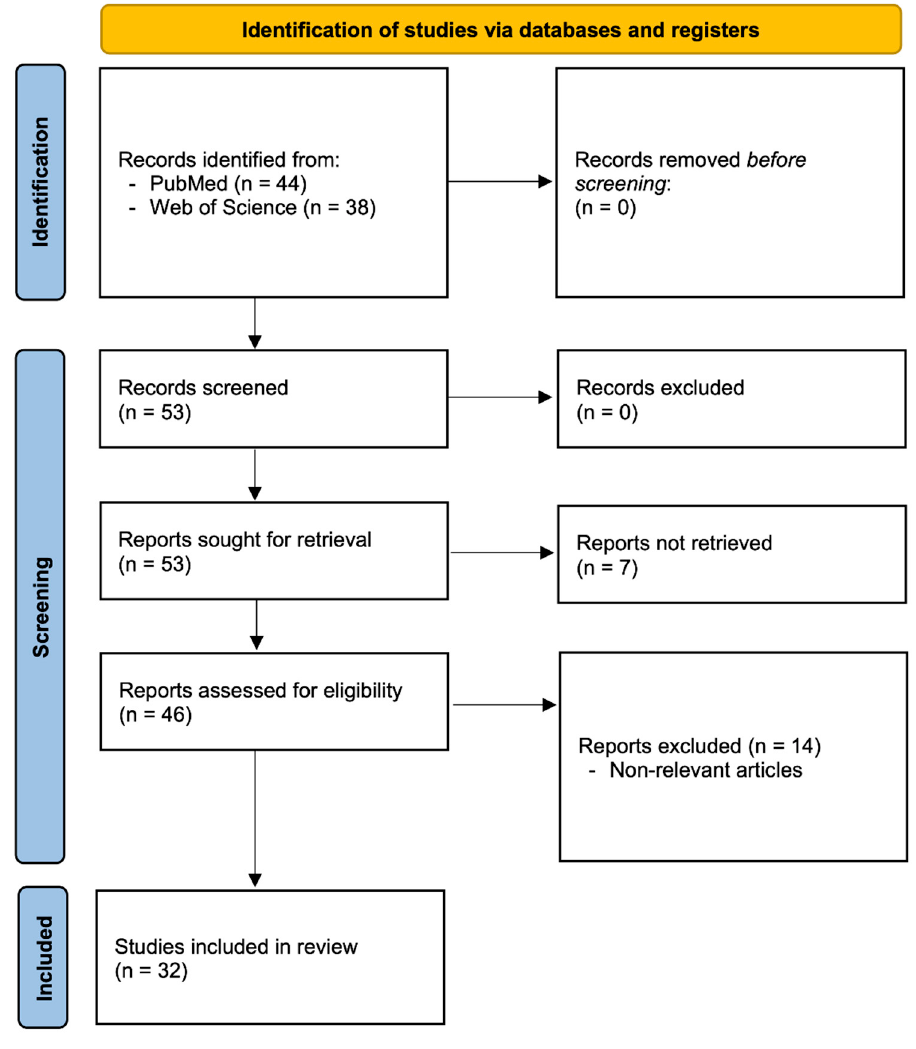
Figure 1. PRISMA guidelines outlining search results and excluded articles.